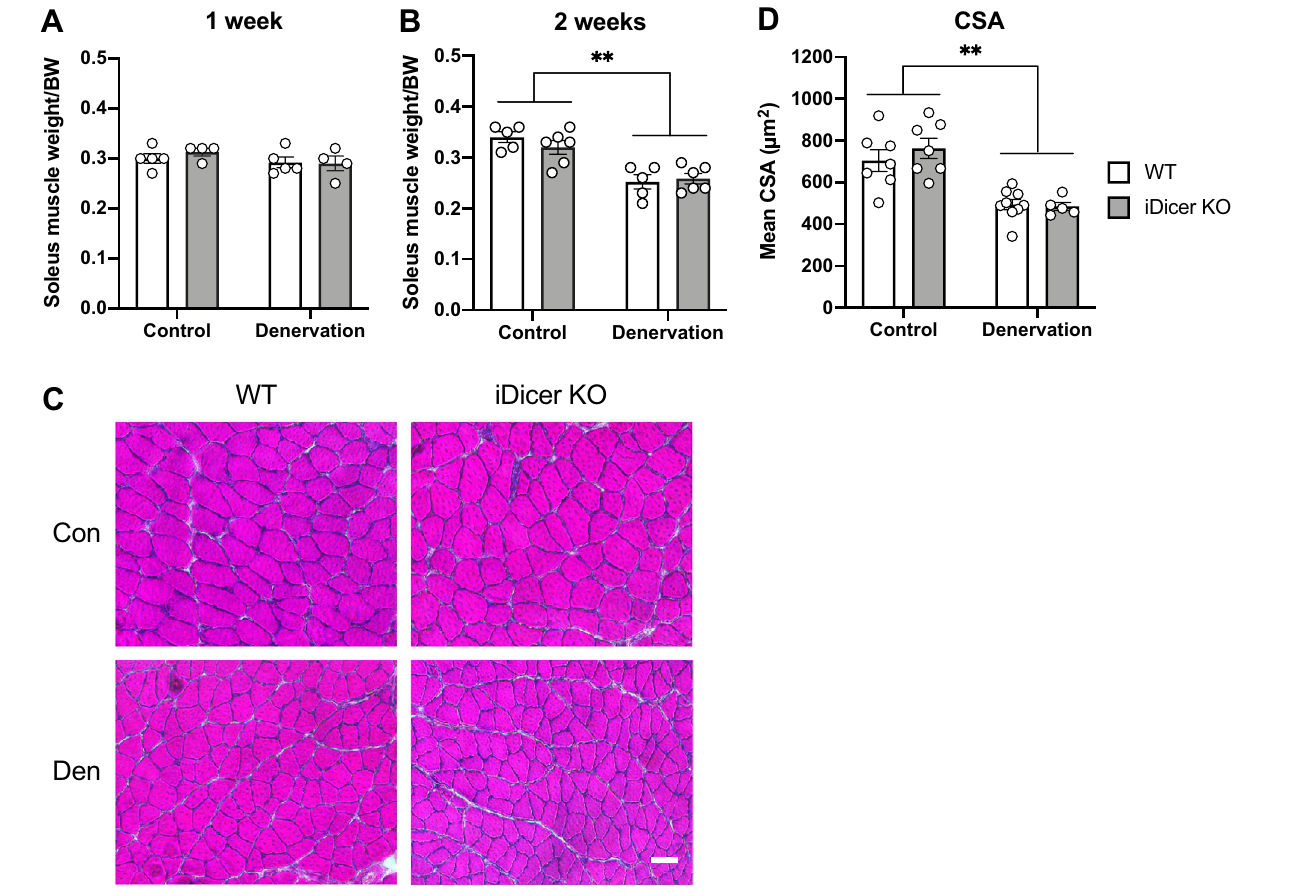
Figure 4. Denervation-induced atrophy of slow-twitch soleus muscles in the iDicer knockout mice. ( A , B ) Changes of soleus muscle weight after 1 week ( A ) and 2 weeks ( B ) of denervation. At 2 weeks after denervation, soleus muscle weight was significantly reduced in both WT and iDicer KO mice (Denervation, P < 0.01), while inducible Dicer deletion did not affect denervation-induced soleus muscle atrophy (n = 4–6). ( C ) Representative images of sections of control and denervated soleus muscles stained with hematoxylin–eosin (H&E). ( D ) Denervation caused a reduction in cross-sectional areas (CSA) of soleus muscle fibers in both WT and iDicer KO mice (Denervation, P < 0.01). There were no differences in muscle fiber atrophy between genotypes (n = 5–10). **P < 0.01. Scale bar = 50